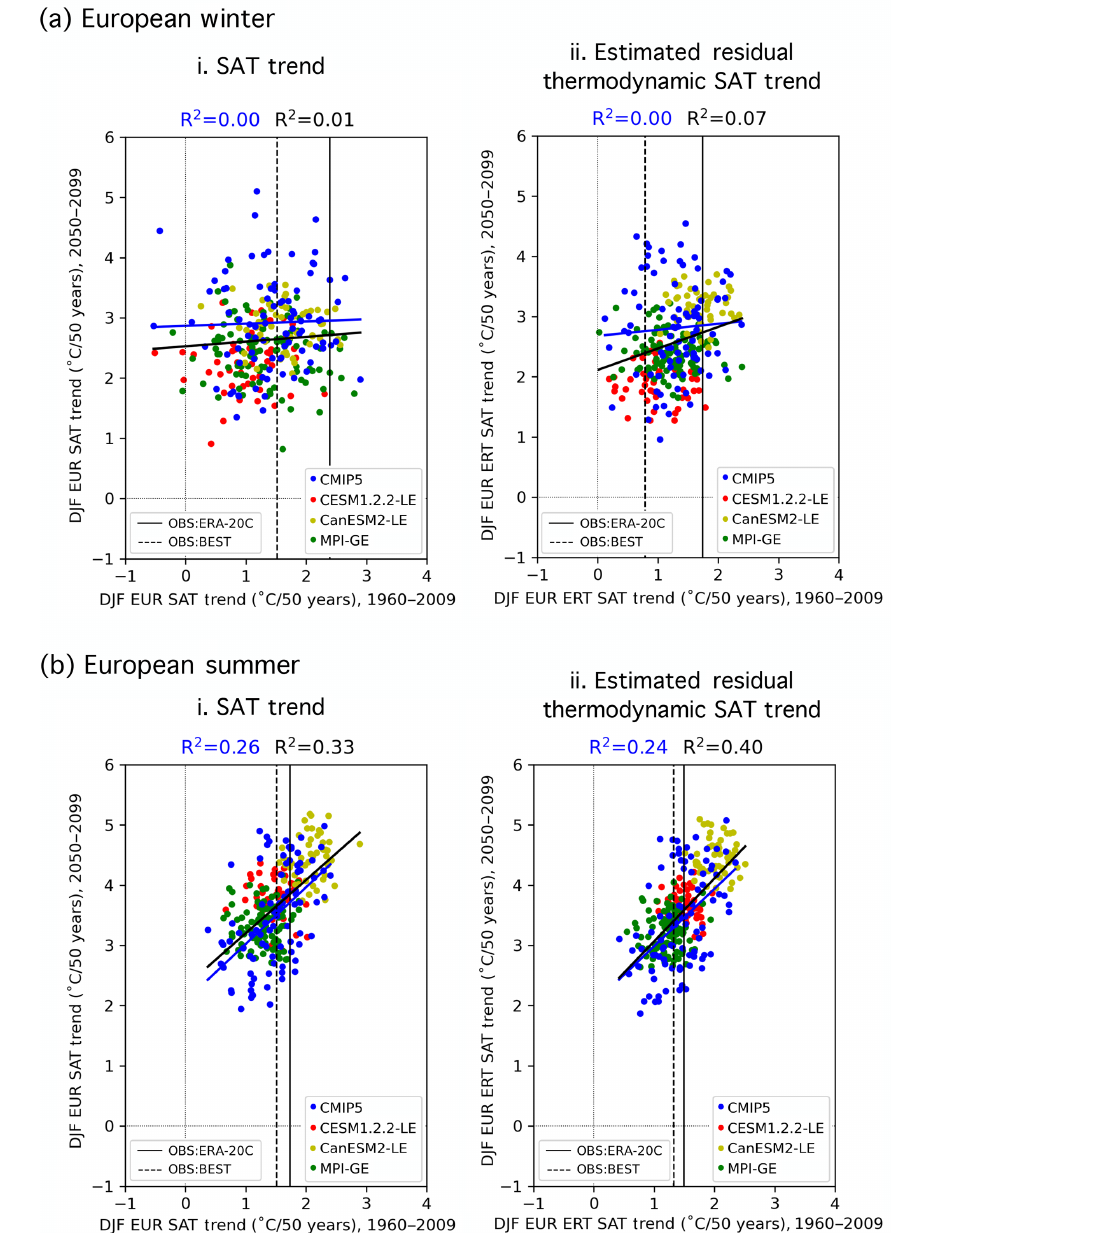
Figure 2. Predictor relationships of the domain-averaged 50-year trends of (a) DJF and (b) JJA European (EUR) SAT. 50-year raw trends are shown in (i), and 50-year estimated residual thermodynamic trends are shown in (ii). In each panel, 1960–2009 is shown on the abscissa and 2050–2099 is shown on the ordinate. ERA-20C (BEST) observational estimates of the 1960–2009 trends are indicated by the solid (dashed) vertical lines. Least-squares regression fits (solid lines) and R 2 values computed solely for the CMIP5 output are shown in blue, and those computed for ALL output (CMIP5 and the three SMILEs) are shown in